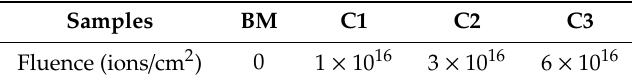
Table 1. Carbon ion implantation